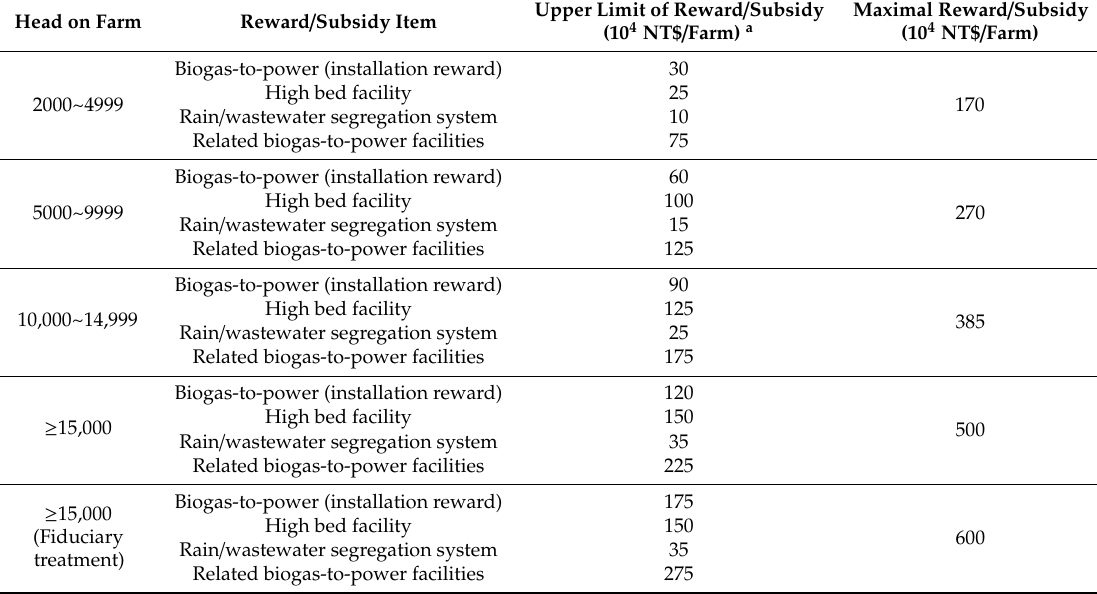
Table 4. The rewards and subsidies for the biogas-to-power and related facilities by the Council of Agriculture (COA) in